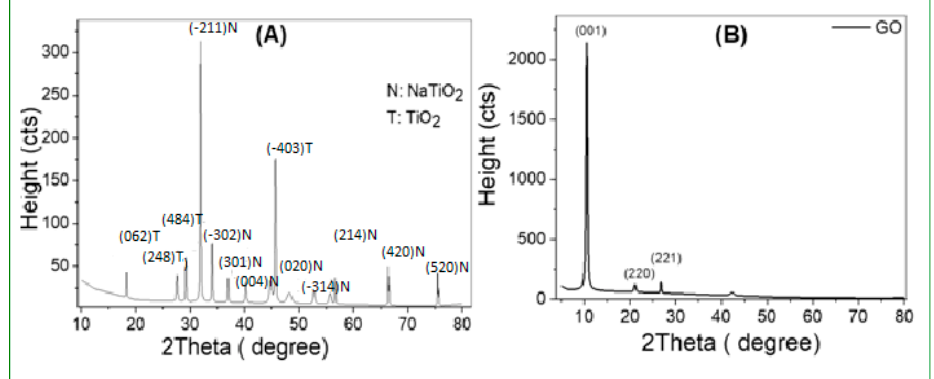
Figure 4. XRD charts of ( A )TiO 2 nanoribbons and ( B ) GO nanostructure. Using values of W (full width at half maximum) for XRD peaks, the average crystal- lite size of TiO 2 , NaTiO 2 , and GO is estimated using Scherrer’s equation: